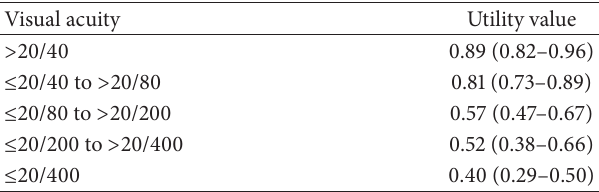
Table 3: Utilities for each visual acuity